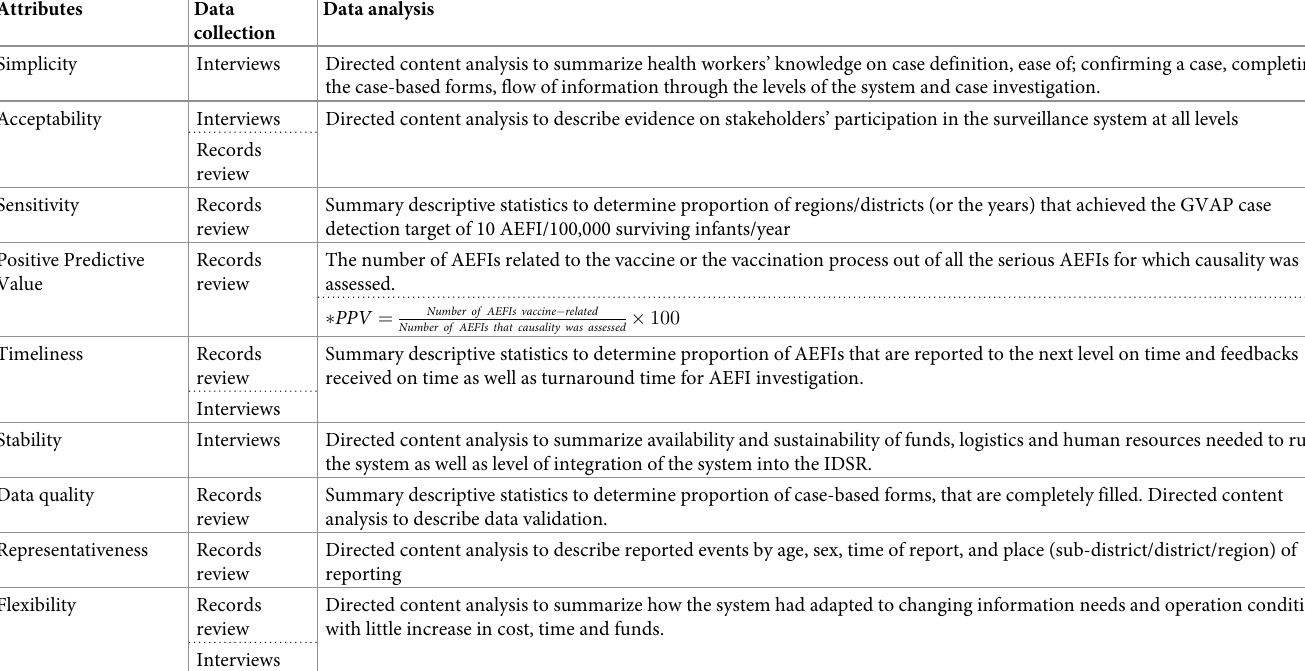
Table 1. Assessment of attributes of the AEFI surveillance